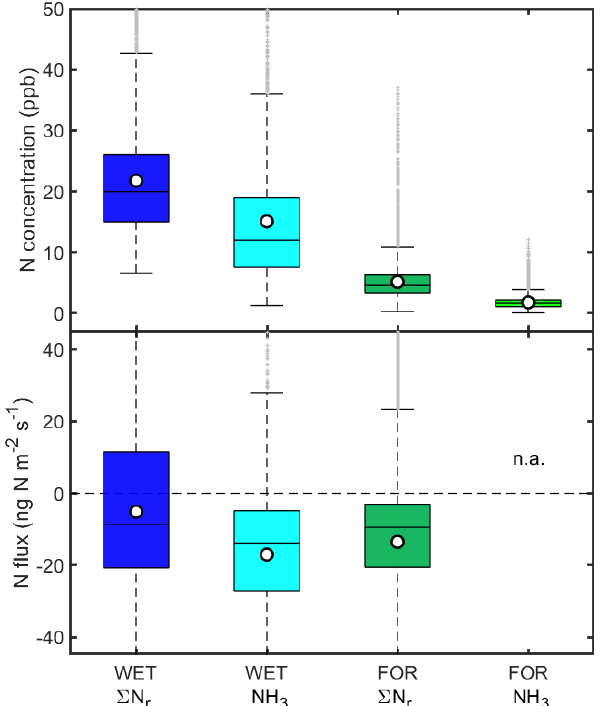
Figure 4. Summary of campaign concentrations and fluxes. White circles with black edges represent the campaign mean, horizontal lines within boxes indicate the median, vertical box dimensions in- dicate lower and upper quartile values, whiskers represent the in- terquartile range, and outliers from this range are plotted as grey crosses; positive flux values indicate emission, and negative flux values indicate deposition of nitrogen.